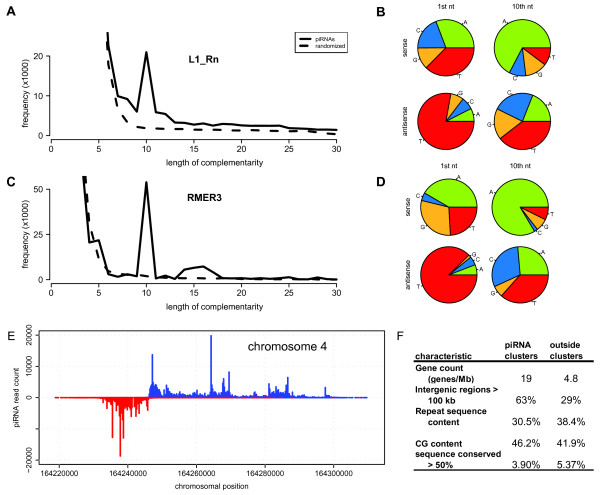
piRNAs in the rat testis. A, C) Complementarity of reads derived from repeats, calculated from the 5' terminus. A) L1 transposon, C) Retroviral repeat RMER3. Dashed lines indicate randomly selected short fragments from the same region. B, D) Nucleotide content of reads on position 1 and 10 that map to loci described in A and C. E) A typical pachytene piRNA cluster contains reads derived from bidirectional transcription originating from a centrally located common point of origin. Blue: sense, red: antisense. F) Characteristics of pachytene piRNA clusters.